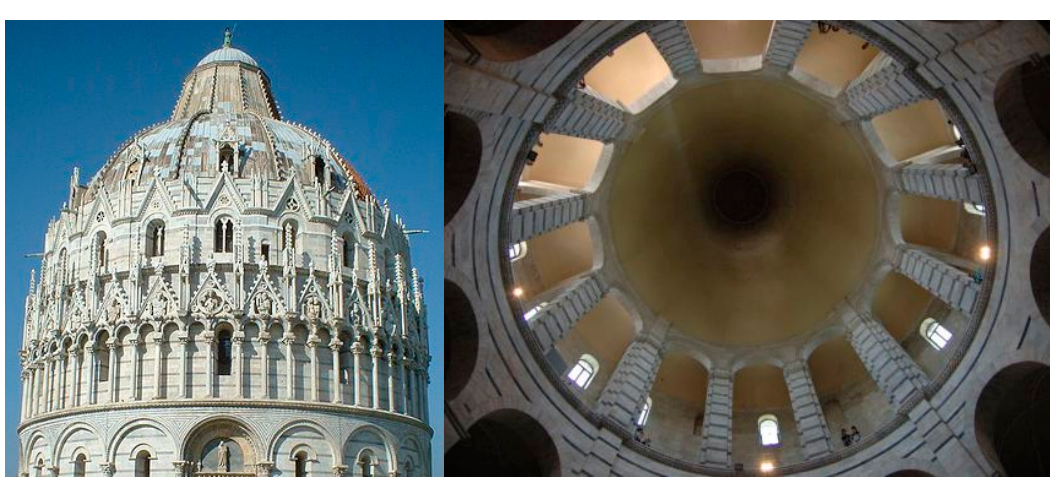
Figure 1. Photos of Pisa baptistery’s dome ( left ) and of its internal gallery structure ( right ). Spheres, discs, and rings represent the simplest optical whispering-gallery resonator geometries and have thus received much attention in the literature over the years. In WGMs, light circulates for a